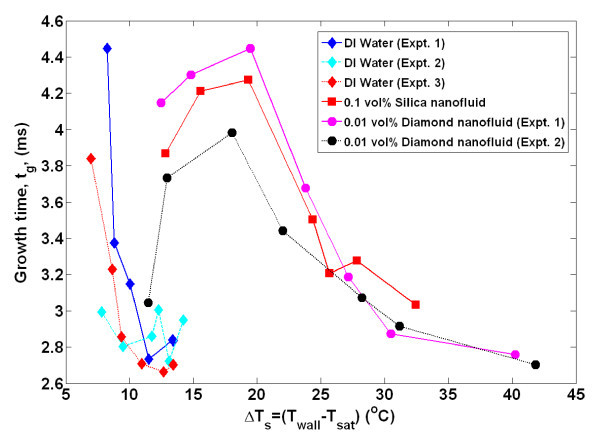
Average growth time as measured by infrared thermometry. Uncertainty in growth time is ± 20%.